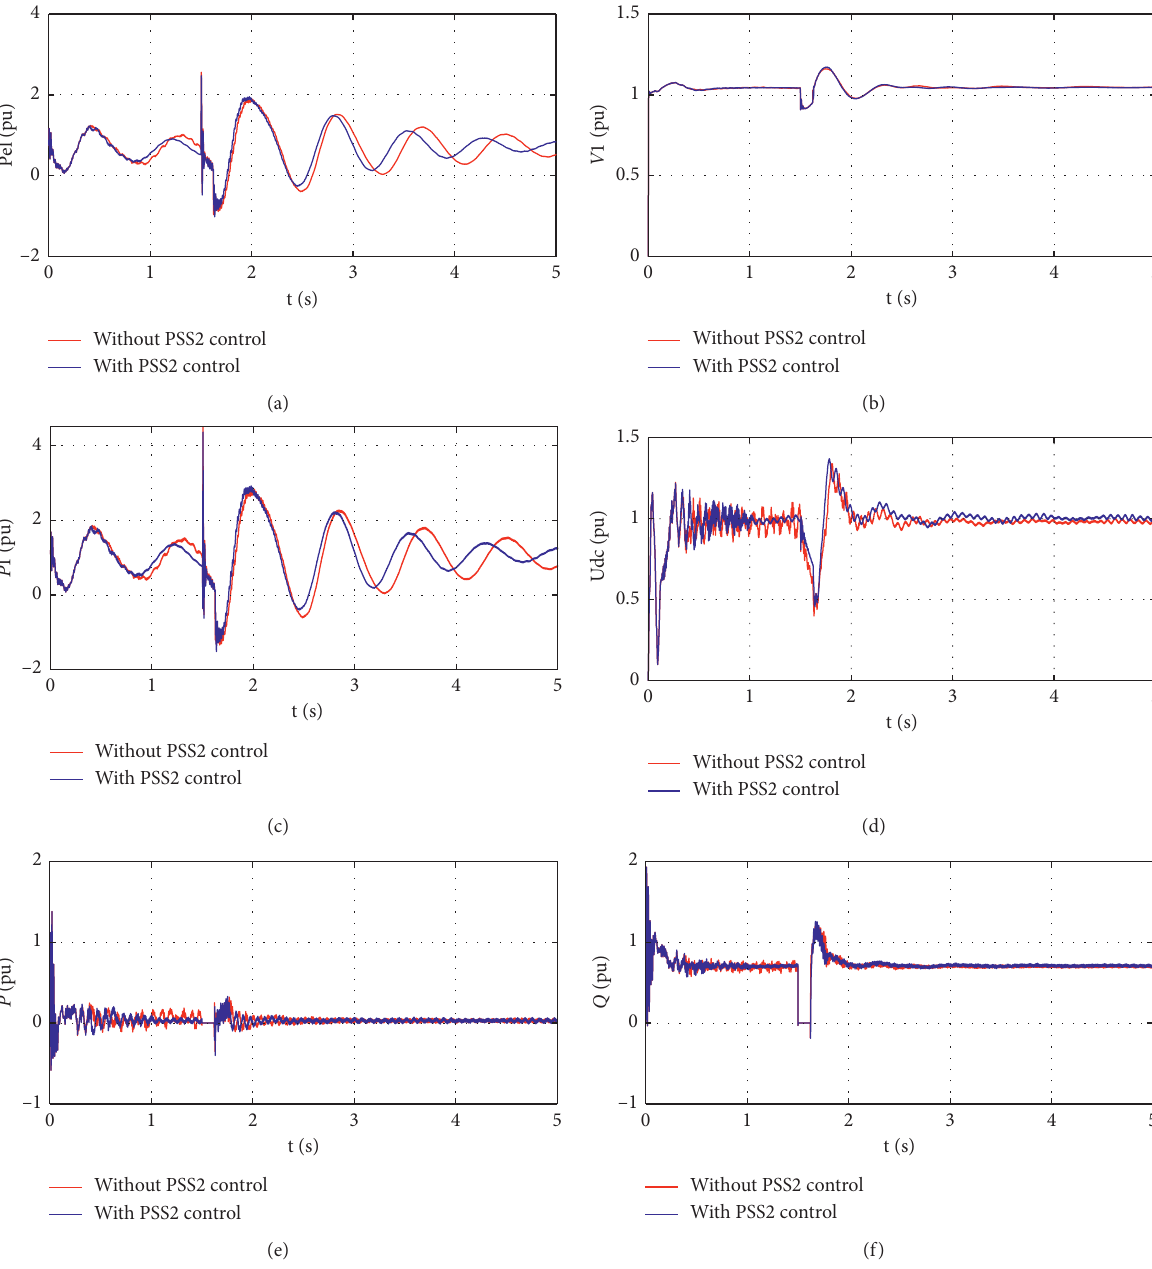
Figure 9: Dynamic response of the system before and after adding PSS2 in the case of the three-phase short-circuit fault. (a) The electromagnetic torque of synchronous generator 1. (b) The voltage of synchronous generator 1. (c) The active power of synchronous generator 1. (d) The direct current voltage of HVDC. (e) The active power of VSC1. (f) The reactive power of